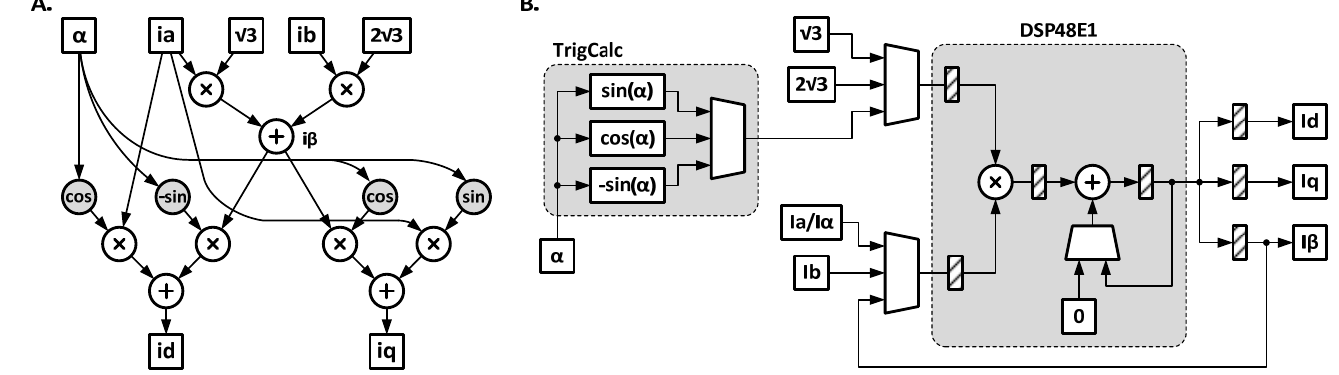
Figure 11. The R2S computation engine data flow graph ( A ) and hardware mapping using DSP48E1 and TrigCalc units ( B ).